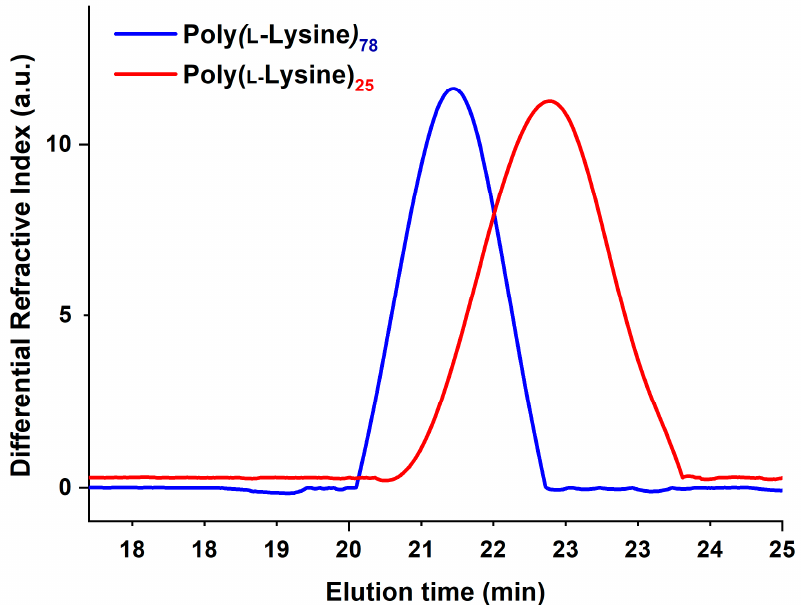
Figure 7. Size Exclusion Chromatography (SEC) eluograms of Poly( L -Lysine) 25 and Poly( L -Lysine) 78 homopolypeptides.